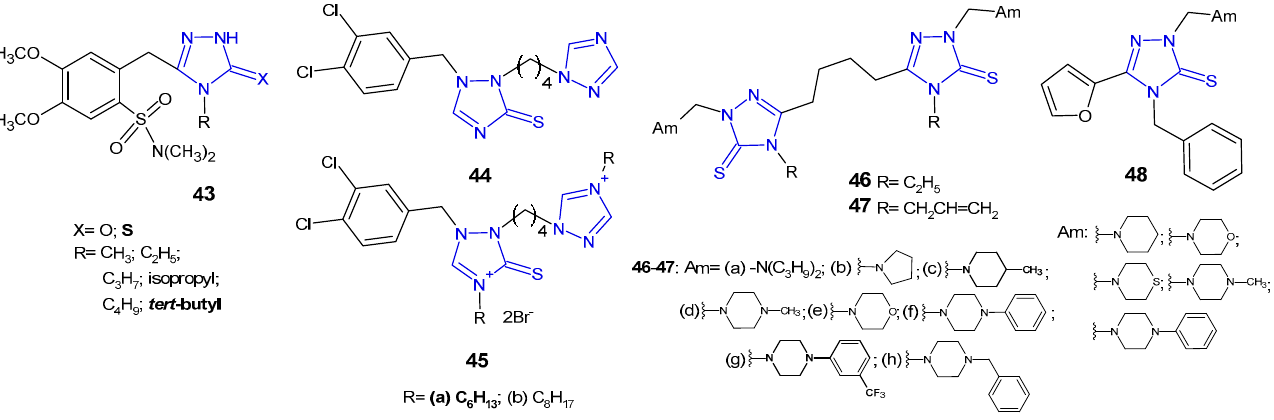
Figure 15. 1,2,4-triazole-3-thiones as antibacterial agents—continued. In 2012, researchers from China synthesized a series of 1-(dihalobenzylo)-1,2,4-triazole- 3-thiols, thioethers and thiones as well as some corresponding triazolium derivatives, and evaluated them for their antimicrobial activity against MRSA, S. aureus , B. subtilis and M. luteus as Gram-positive bacteria, as well as E. coli , S. dysenteriae , P. aeruginosa and E. typhosa as Gram-negative ones. In vitro screening revealed that 3,4-dichlorobenzyl triazole-3-thione 44 and triazoliums 45 (Figure 15) showed the most potent bioactivity against most tested bacteria. Especially hexyl triazolium 45a exhibited comparable or even higher growth inhibitory efficacy for S. aureus (MIC = 2 µ g/mL), E. coli (MIC = 1 µ g/mL), P. aeruginosa (MIC = 4 µ g/mL) and E . typhosa (MIC = 8 µ g/mL) compared with the reference drugs, chloromycin (MICs: 1 µ g/mL; 2 µ g/mL; 16 µ g/mL; 8 µ g/mL, respectively) and norfloxacin (MICs: 0.5 µ g/mL; 4 µ g/mL; 1 µ g/mL; 4 µ g/mL, respectively) [58]. Koparir (2013) synthesized 5,5’-butane-1,4-diylbis[4-ethyl(4-allyl)-2,4-dihydro-3 H